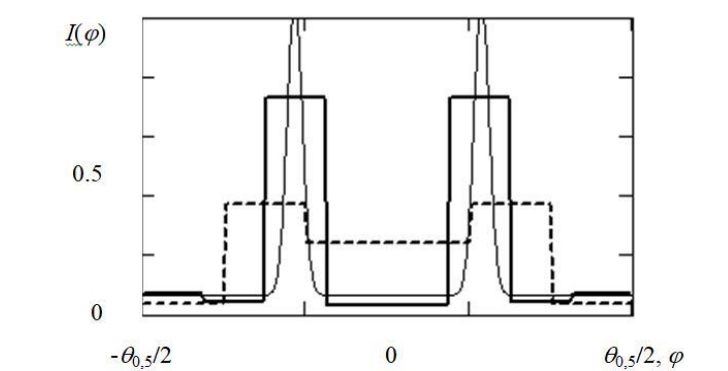
Fig. 3. Reconstructed image of a signal source based on Haar wavelets.